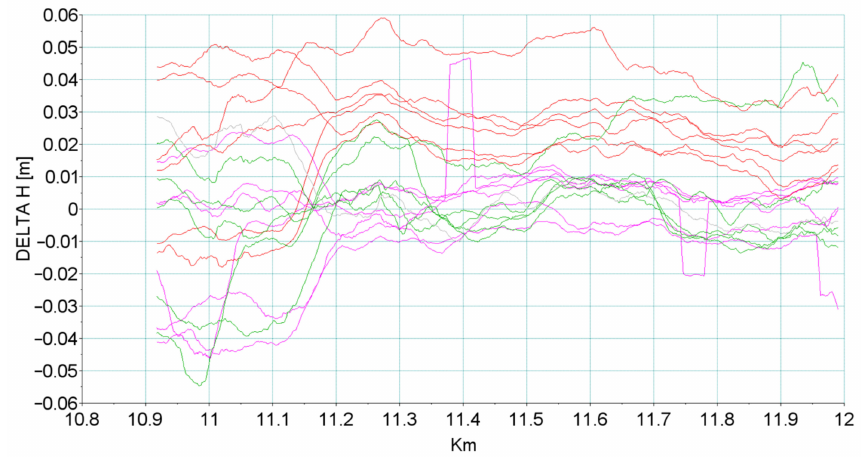
Figure 12. Deviations of the reconstructed track axis in vertical plane for particular measuring instruments with respect to static